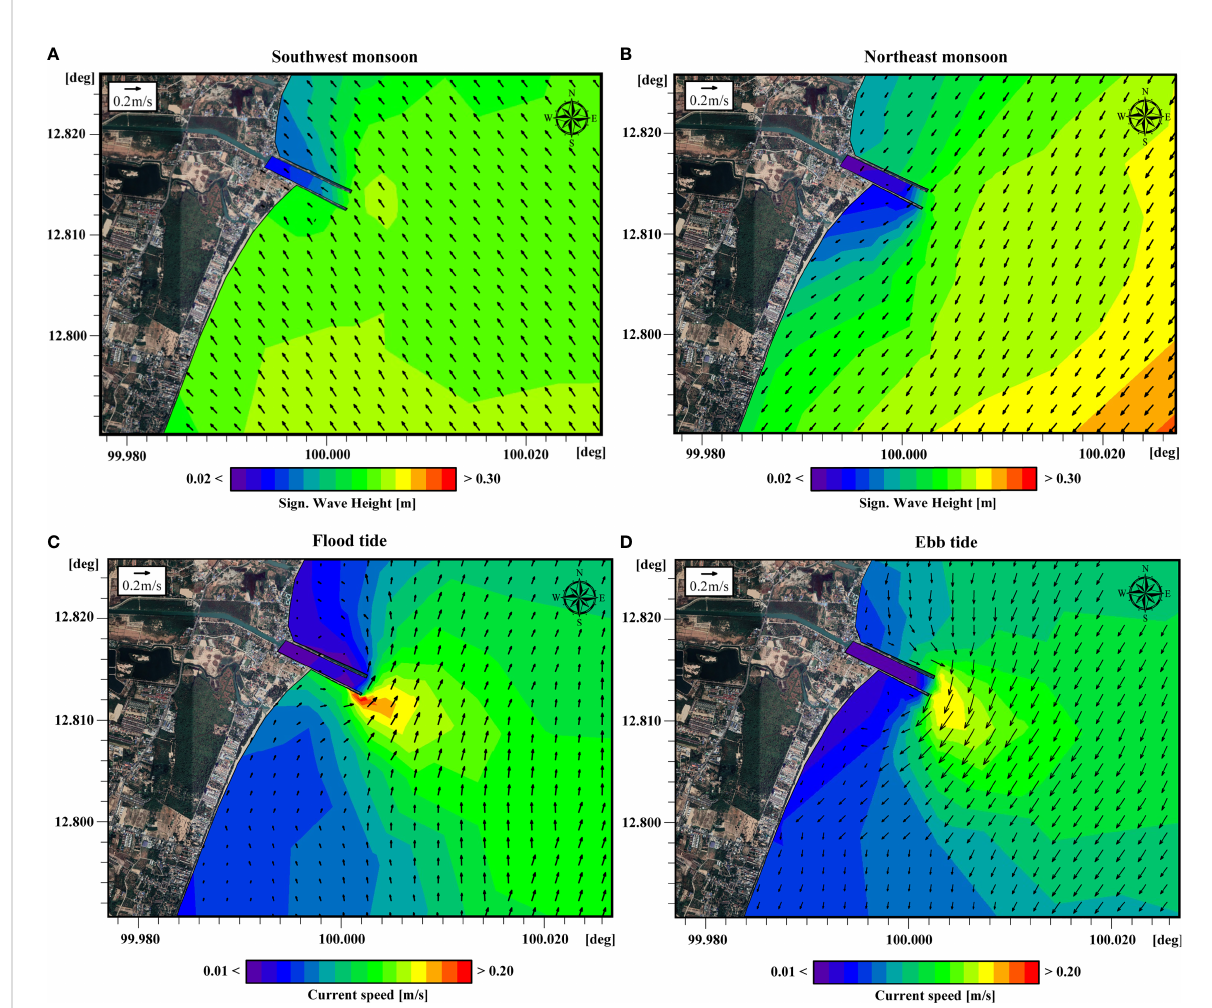
FIGURE 5 Results of MIKE 21 SW and HD at the Cha Am jetty (A) signi fi cant wave height and direction (arrows) during the southwest monsoon, (B) signi fi cant wave height and direction (arrows) during the northeast monsoon, (C) current speed and direction (arrows) during fl ood tide, (D) current speed and direction (arrows) during ebb tide.